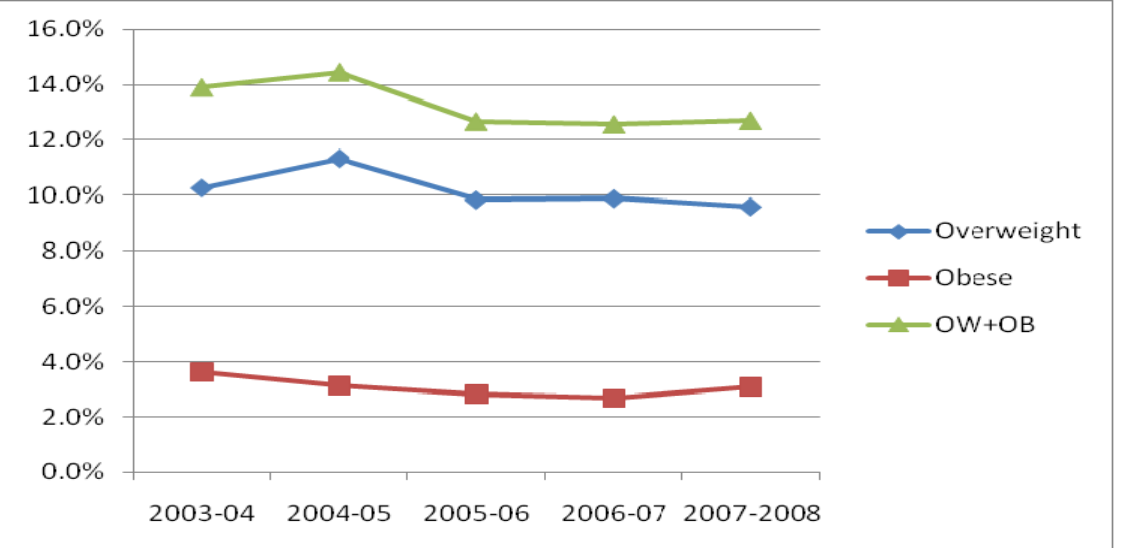
Figure 1 BMI over time for the entire